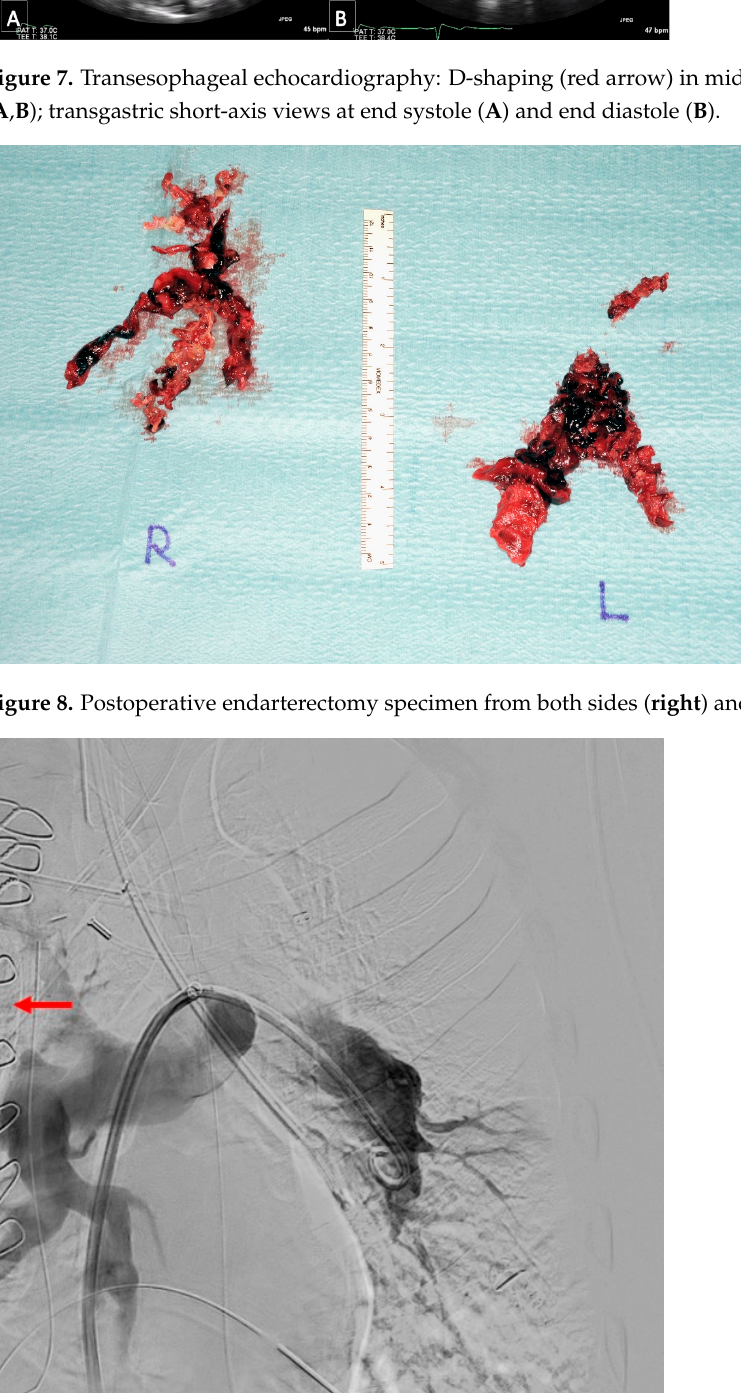
Figure 9. Persistent lack of contrast filling of the left upper lobe artery as well as presenting of the central re-thrombosis (red arrow) after surgery